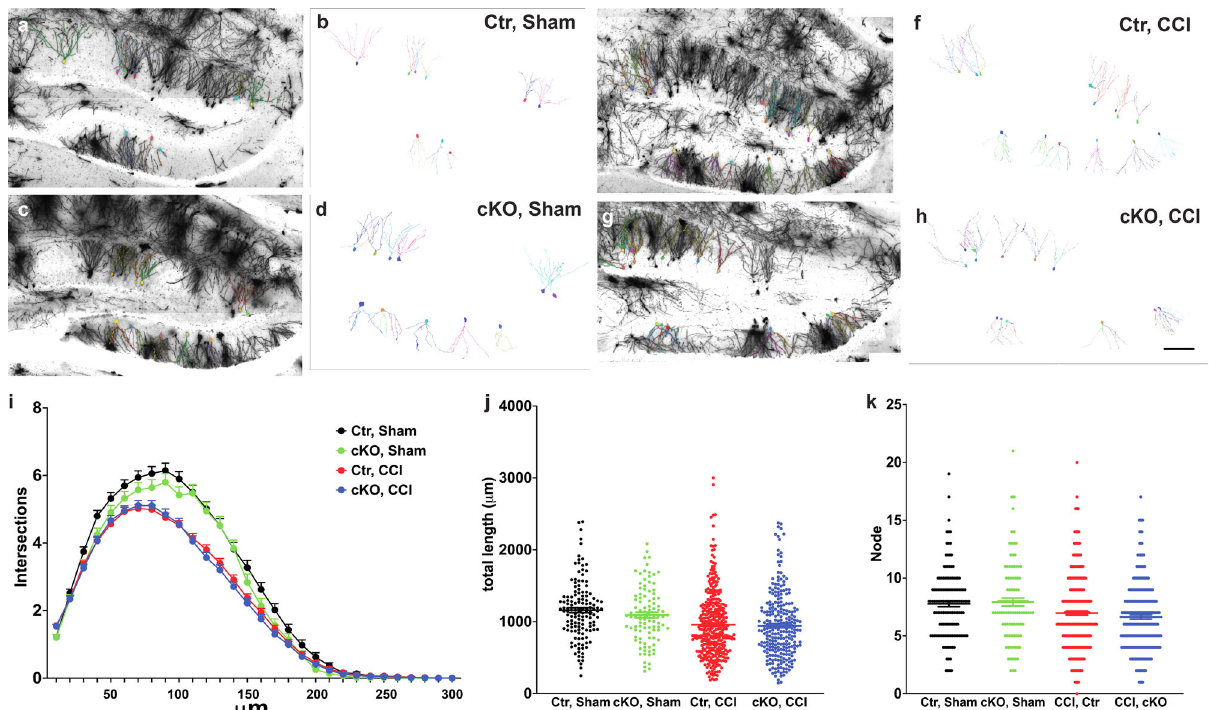
Fig. 3 The morphology of Golgi – Cox-stained neurons in the hippocampus mice without astrocytic ApoE. a – h The left panels demonstrate Golgi – Cox- stained neurons in the dentate gyrus and the right panel depicts individual analyzed neurons. i The dendritic trees of the existing neurons in the dentate gyrus were impaired signi fi cantly in CCI groups but were not affected by the reduction of astrocytic ApoE. j , k CCI resulted in shorter total length and fewer nodes in the existing neurons in the dentate gyrus despite of the genotype. Data are presented as means ± SEM. ****P < 0.0001. Scale bar in ( h ) = 100 µ left, P = 0.0001 vs right, and P < 0.0001 vs opposition; in Ctr – CCI: P = 0.0020 vs left, P = 0.0215 vs right, and P = 0.0296